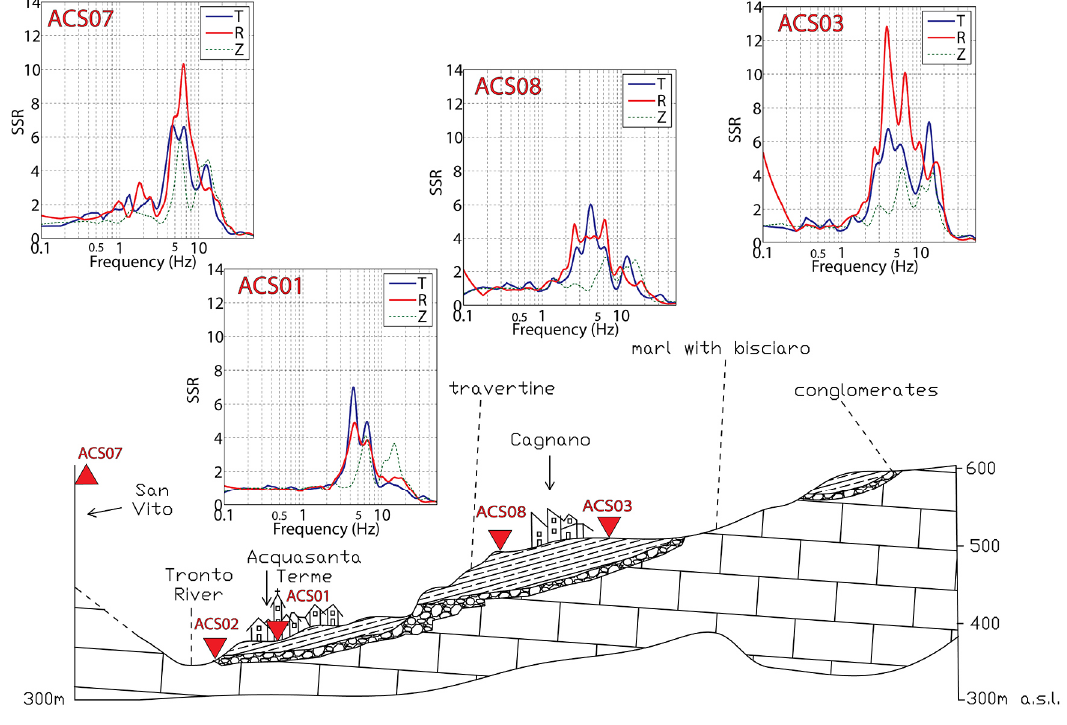
F igure 2. Projection of the linear array in Figure 1 along 2D profile showing the near-surface geology (modi- fied by [Boni and Colacicchi, 1966]). The standard spectral ratio is shown for each seismic